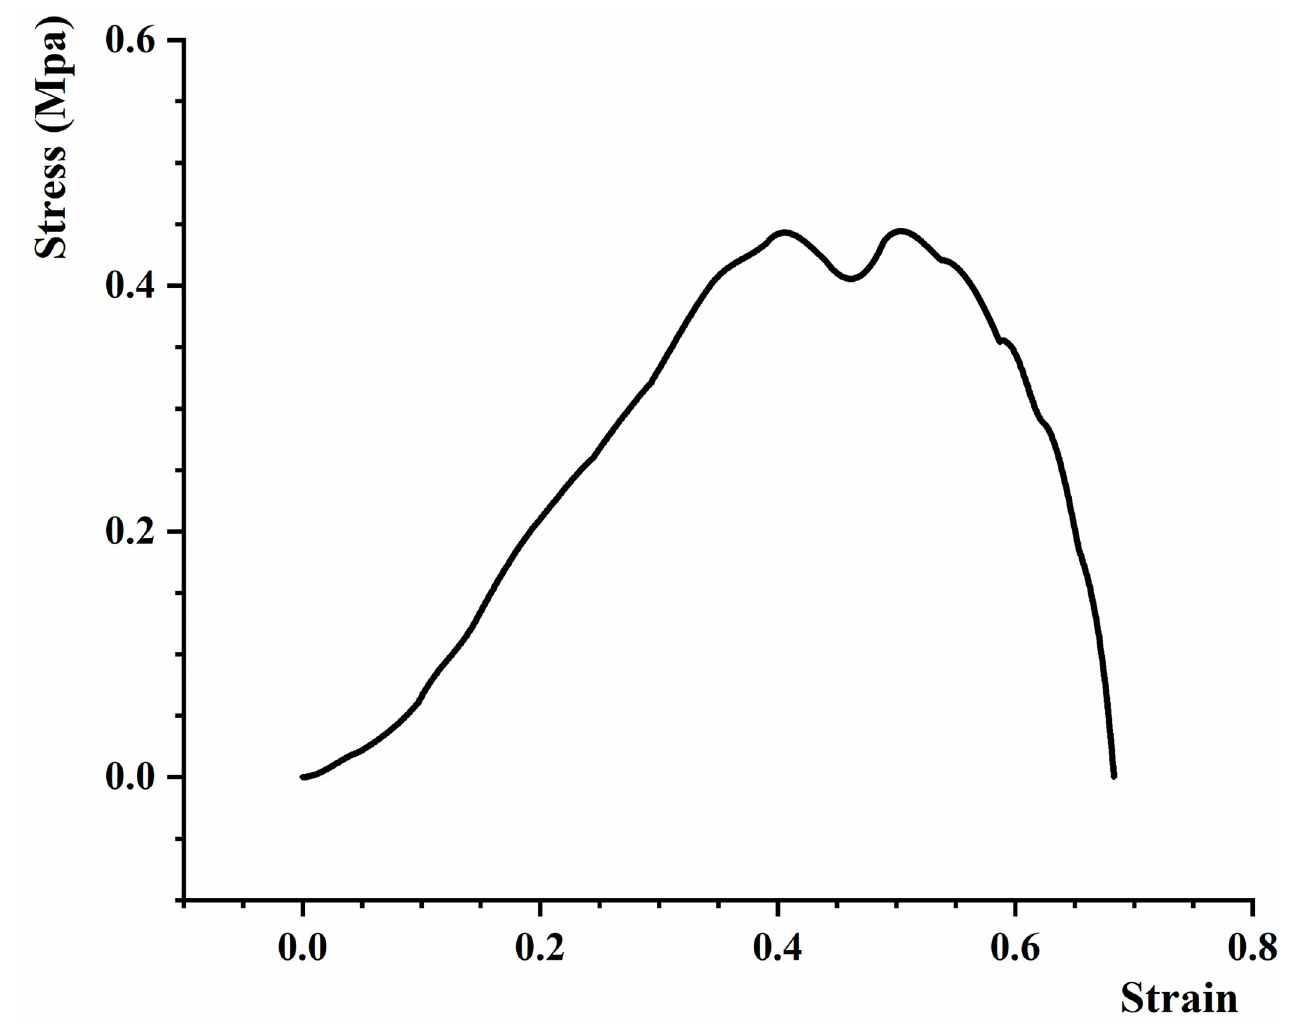
Fig 17. A typical stress-strain curve.